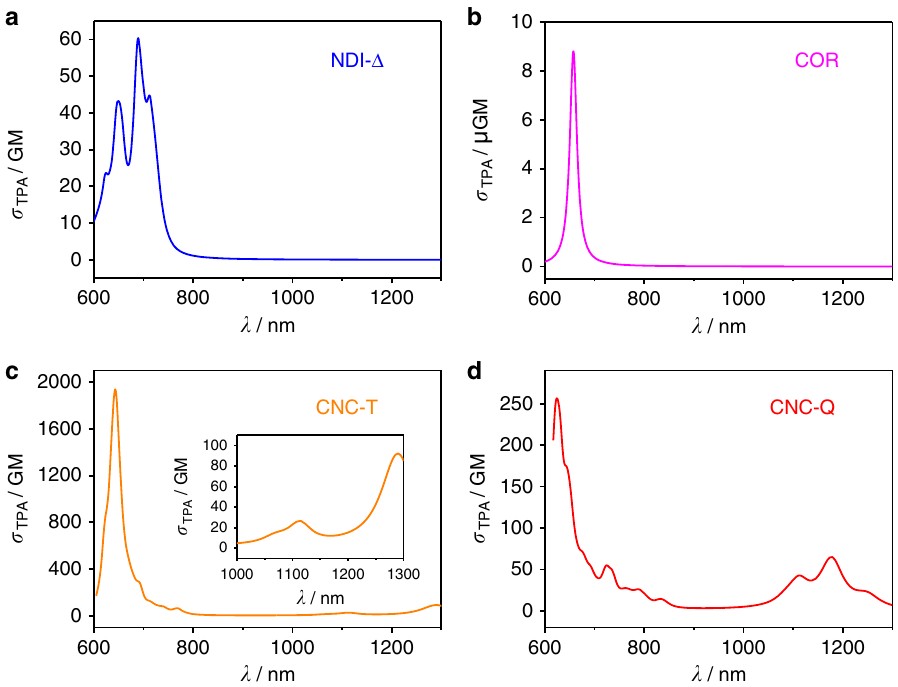
Fig. 9 Second linear response TDDFT calculations. The simulated two-photon excited spectra of a NDI- Δ , b COR , c CNC-T and d CNC-Q . The inset in c displays a magni fi ed simulated two-photon excited spectrum of CNC-T in the region of 1000 – 1300